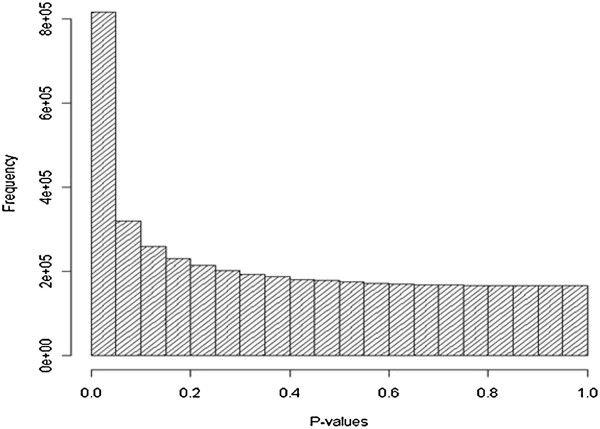
Histogram of P-values for the negative associations between miRNA expression and mRNA expression. Note the enrichment for low p-values, suggesting the presence of true signals.